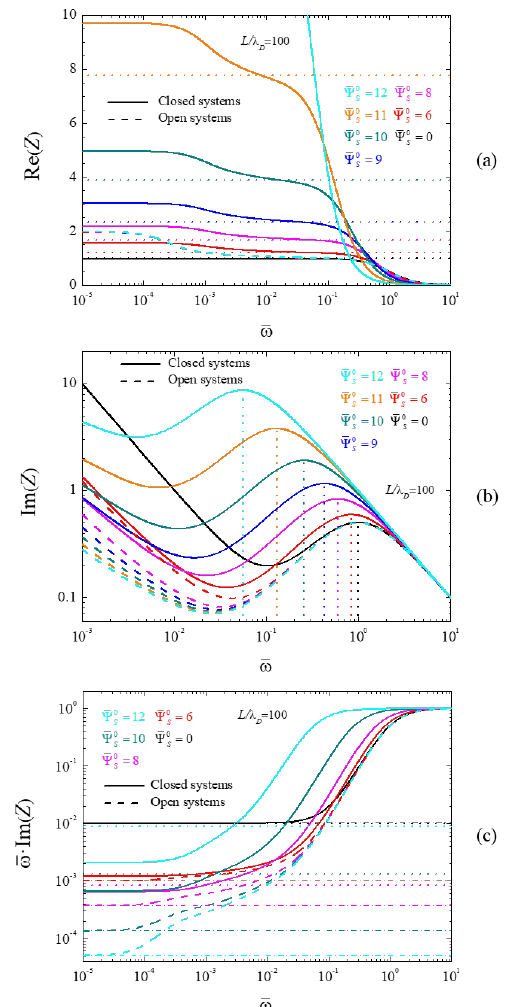
Figure 5. Spectra of the real part of the impedance ( a ), the imaginary part ( b ), and the imaginary part multiplied by the angular frequency ( c ), calculated for the indicated dimensionless surface potential values and for L / λ D = 100. Dot and dash-dot straight lines (closed and open cells respectively) correspond to the following: ( a ) Real part of the impedance at frequencies between both dispersions, Equation (61) for open or (62) for closed cells; ( b ) characteristic frequency of the high-frequency dispersion, Equation (60) for closed cells; ( c ) low-frequency limit of the imaginary part of the impedance multiplied by the frequency, Equations (63), (64), and (25) for closed or Equation (28) for open